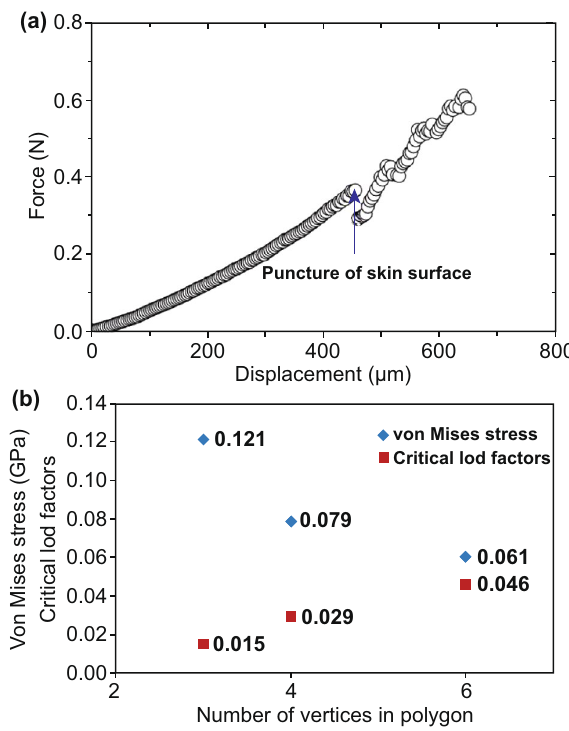
Fig. 8 a General force–displacement behavior of a microneedle, plotted by FEM simulation. Reprinted from Ref. [107] with permis- sion from Taylor and Francis. b Valuation of the triangle-, square-, and hexagon-based MNs based on their Von Mises stress and critical load factor. Reprinted from Ref. [111] with permission from